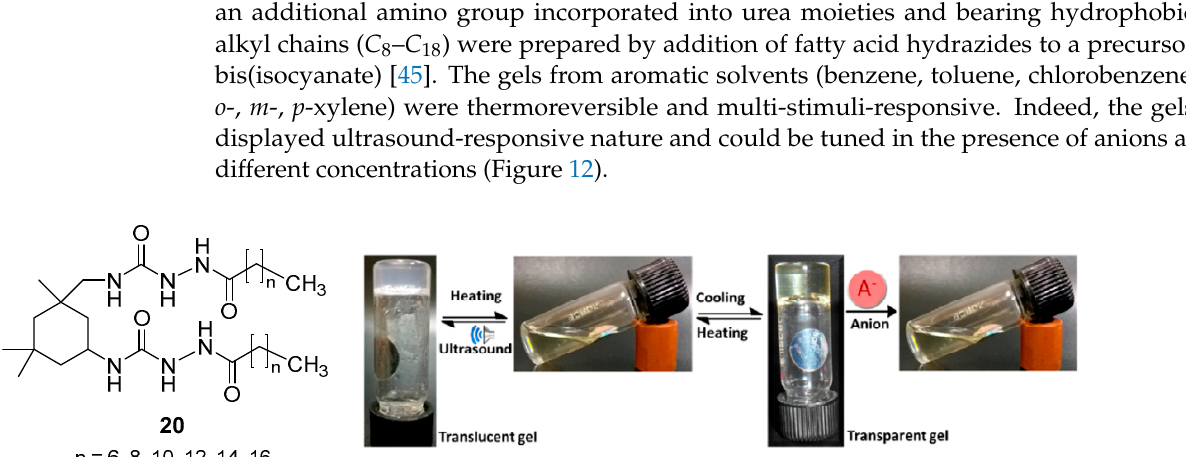
Figure 13. Structures of 1,3,5-cyclohexanetricarboxamide-based organogellators 18 and hydrogela-